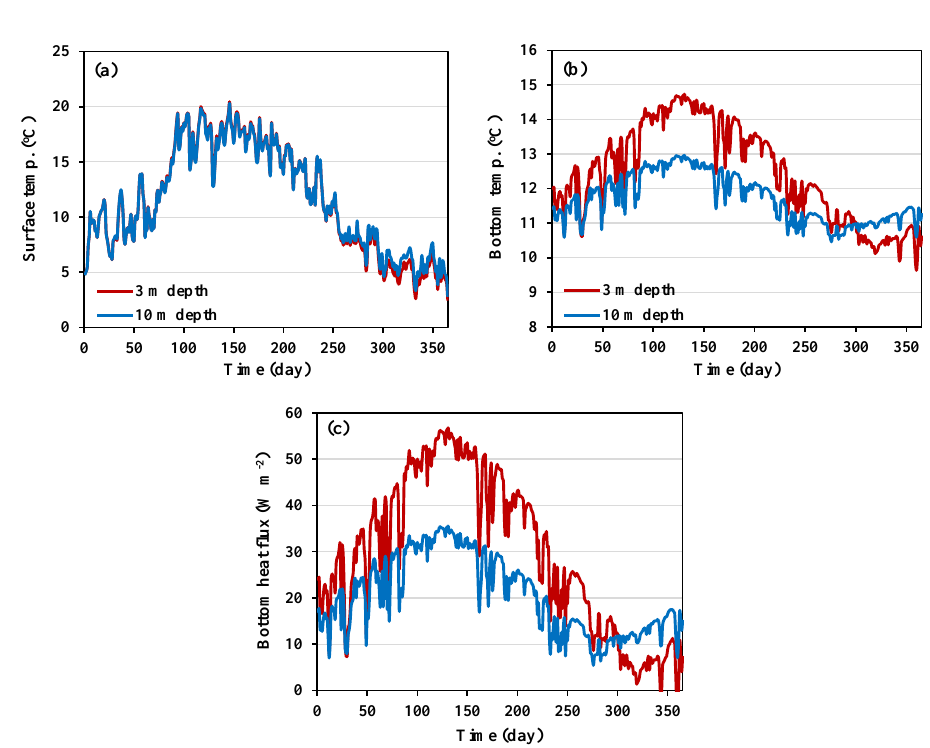
Figure B1. The effect of reservoir depth on surface (a) and bottom (b) temperature of the uncovered reservoir considering bottom heat flux towards the underlining soil layer (c) ; the soil temperature at thermal decay depth ( T sZ ) was assumed to be 10 ◦ C.